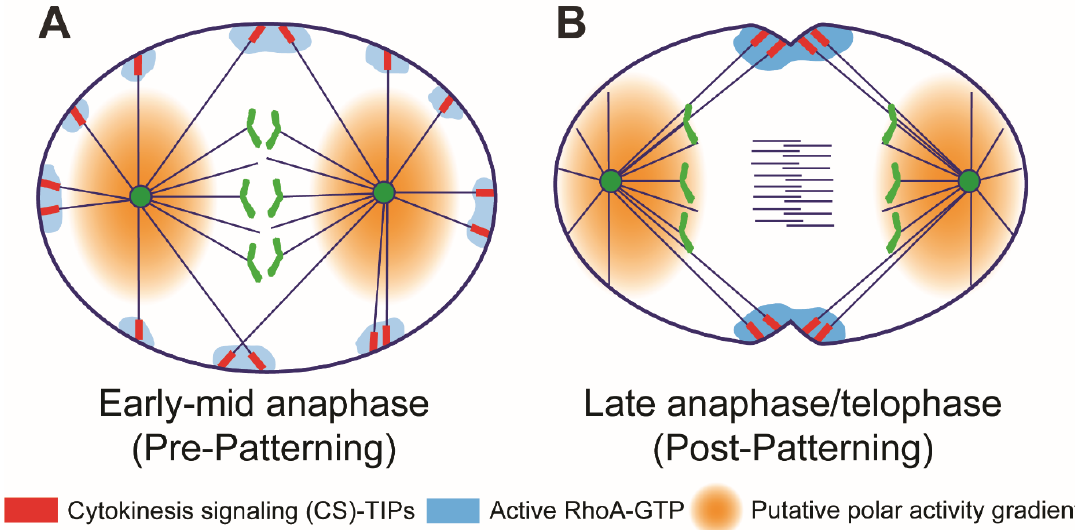
Figure 2. Two sides of the same coin? ( A ) Cytokinesis signaling molecules localize to the plus-ends of astral MTs (referred to as cytokinesis signaling (CS)-TIPs; shown in red) within minutes of anaphase onset and activate RhoA (shown in blue) upon cortical contact. In this model, a putative polar gradient (shown in orange gradient) inhibits the localization of CS-TIP components to MT plus-ends. During the “Pre-Patterning” phase in early-mid anaphase, the polar gradient does not reach astral MT plus-ends and; therefore, astral MT plus-ends in both the polar and equatorial regions are capable of triggering transient RhoA activation. ( B ) The unexplained phenomenon of CS-TIP patterning involves the retention of CS-TIPs on equatorial astral MTs and the loss of CS-TIPs from polar astral MTs during late anaphase and telophase (referred to as ‘Post-Patterning’). In this model, polar CS-TIPs are lost as the spindle poles approach the polar cortex and the inhibitory polar gradient envelops polar astral MT plus-ends. Since the inhibitory polar gradient still does not reach the equatorial MT plus-ends, CS-TIPs in this area are retained and sustained RhoA activation supports cleavage furrow assembly and ingression in the equatorial region.